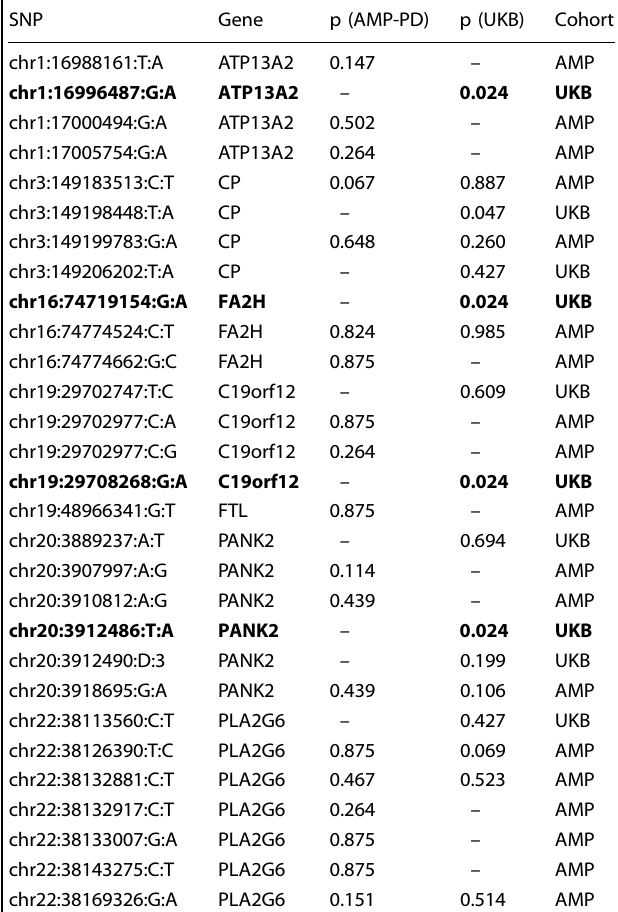
Table 1. Summary of variants in NBIA related genes with higher frequency in PD cases versus controls, SNP = Single Nucleotide Polymorphism, p = P